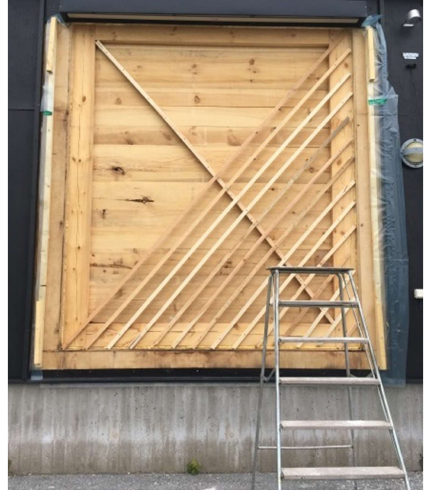
Figure 6. Wooden slats are placed diagonally on the timber for carrying the render.